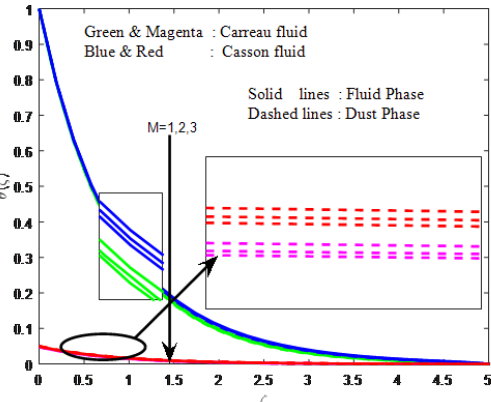
Fig. 6: Impact of Q H on temperature profiles.